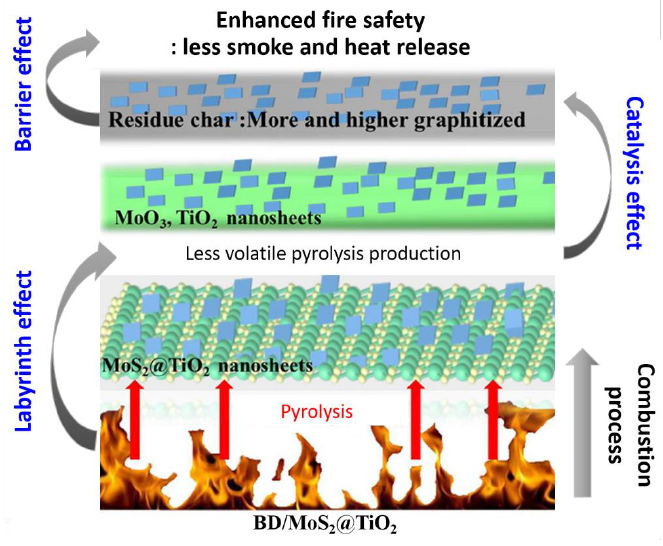
Figure 34. Schematic of proposed flame-retardant process for MoS 2 @TiO 2 in BD nanocomposites. Reprinted with permission from Ref. [232]. Copyright 2019, Elsevier.